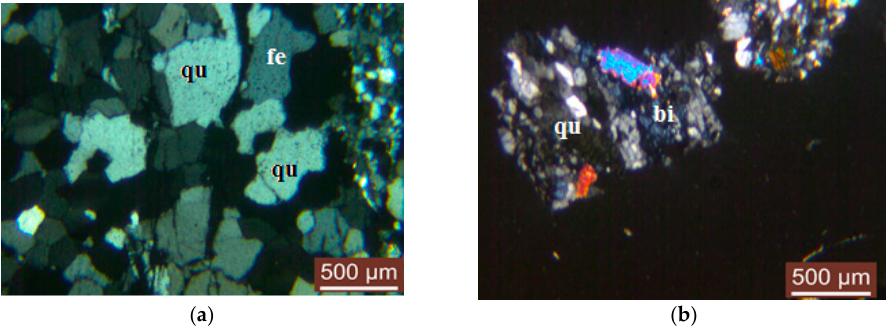
Figure 2. Microscopic images of ( a ) feldspar (fe), quartz (qu) and ( b ) quartz (qu), biotite (bi) in the Augen-Gneiss sample.